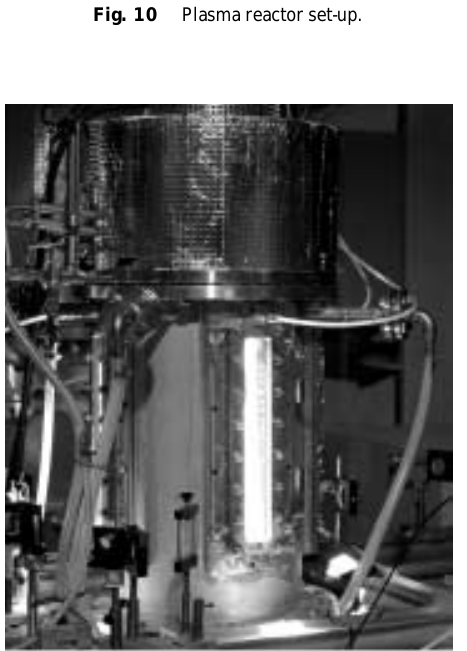
Fig. 11 Plasma reactor during